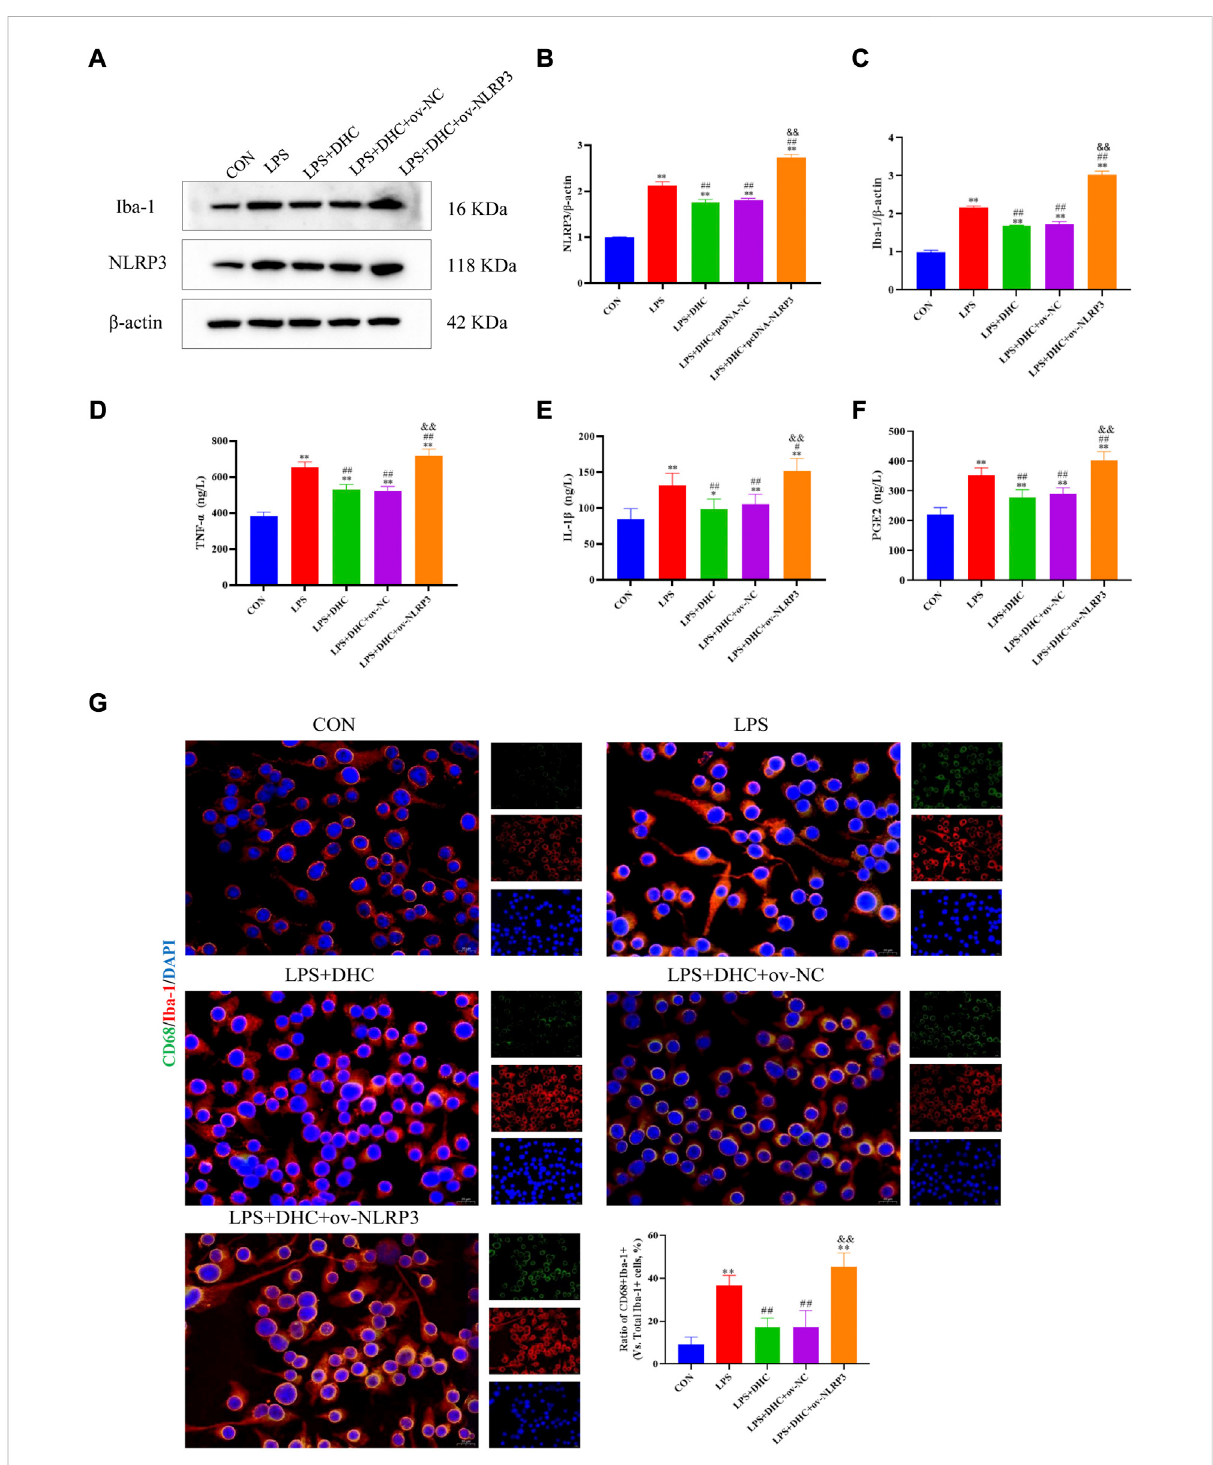
FIGURE 9 Effects of DHC on LPS-induced activation of microglia. BV2 cells were incubated with DHC (100 mg/L) and 100 ng/ml LPS for 12 h ov-NC or ov-NLRP3plasmidwastransfectedintoBV2cells6 hbeforeLPSinduction. (A) TheexpressionlevelsofNLRP3andIba-1proteinweredeterminedby western blotting; (B) the relative intensity of NLRP3 protein was shown as a bar graph; (C) the relative intensity of Iba-1 protein was shown as a bar graph; (D) concentrationofTNF- α ineachgroup; (E) concentrationofIL-1 α ineachgroup; (F) concentrationofPGE2ineachgroup;and (G) the microglia was subjectedto immuno fl uorescentstainingwith CD68 (green), Iba-1 (red), and DAPI (blue). * p < 0.05 and ** p < 0.01, compared with the control (CON) group; # p < 0.05 and ## p < 0.01, compared with the LPS group; && p < 0.01, compared with the LPS + DHC